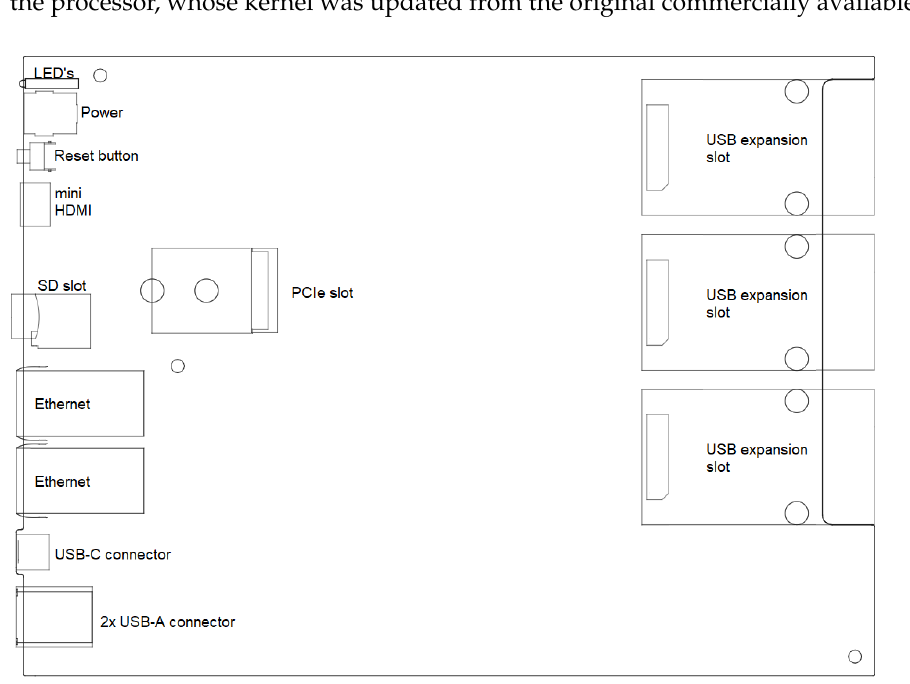
Figure 16. GWEN carrier board—bottom view (flipped